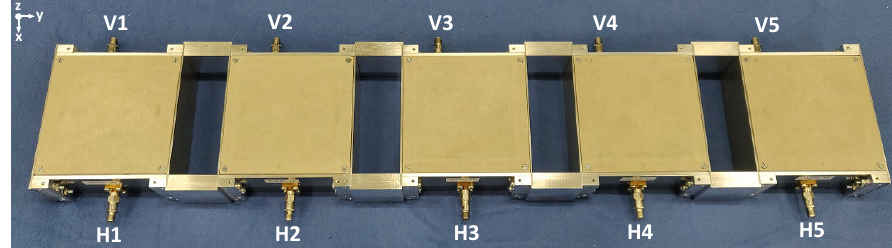
Figure 7. Manufactured normal array.